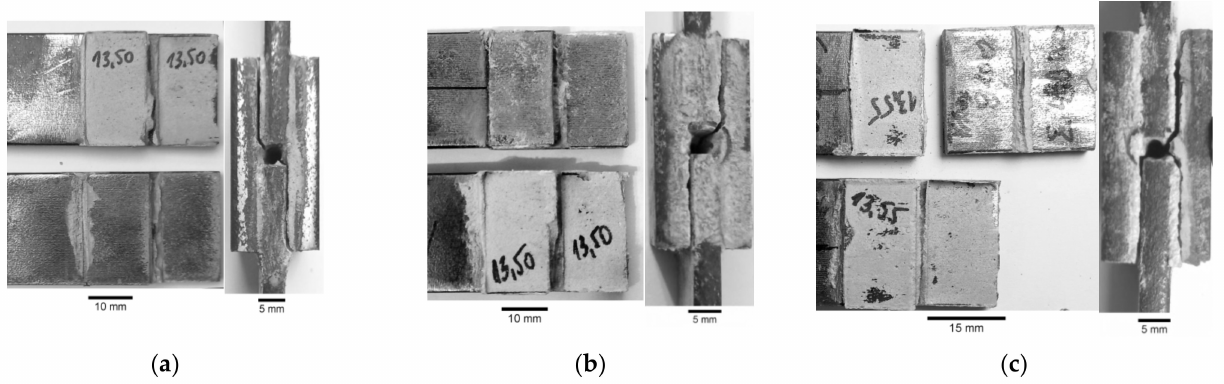
Figure 17. Failure modes of samples with steel overlays with visible steel/adhesive interfacial